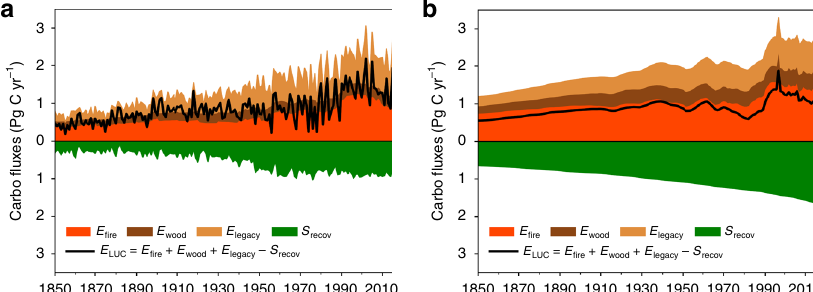
Fig. 4 Comparison of E LUC by ORCHIDEE and the bookkeeping model. a ORCHIDEE model. b The HN2017 bookkeeping model. Refer to Fig. 1 for the meanings of the four component fl uxes of E LUC